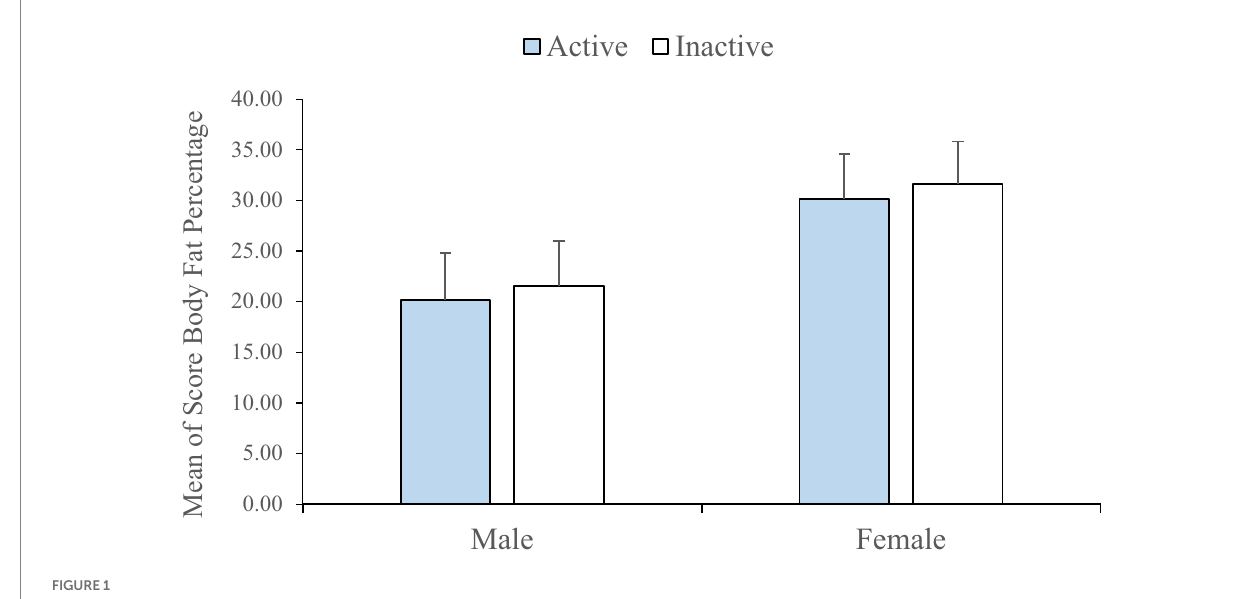
FIGURE 1 Mean body fat percentage in two active and inactive groups based on gender.